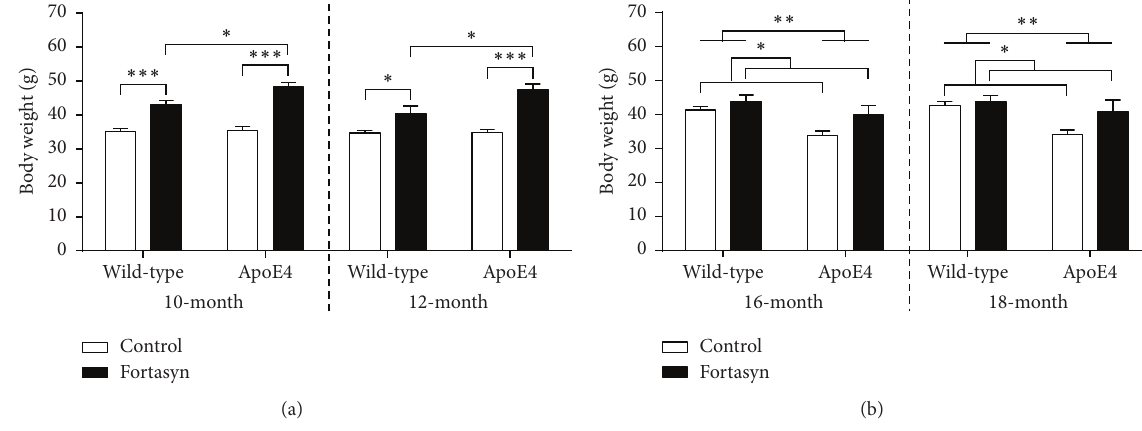
Figure 2: Body weight was measured in 10–12-month-old (a) and 16–18-month-old ApoE4 and wild-type (WT) mice. (a) At 10 months of age, ApoE4 and also wild-type mice on Fortasyn were significantly heavier than on control diet (ApoE4: 𝑝 < 0.001 ; wild-type: 𝑝 < 0.001 ). Only on Fortasyn diet was a genotype effect found showing a higher weight of ApoE4 mice compared with wild-type mice ( 𝑝 = 0.015 ). Again at 12 months of age, all animals on Fortasyn diet showed an increased body weight compared to animals on control diet (ApoE4: 𝑝 < 0.001 ; wild-type: 𝑝 = 0.019 ). ApoE4 mice on Fortasyn were heavier than wild-type mice on the same diet ( 𝑝 = 0.013 ). (b) At 16 and also 18 months of age, ApoE4 mice were significantly lighter than wild-type mice (16-month: 𝑝 = 0.003 ; 18-month: 𝑝 = 0.005 ). Furthermore, all animals on Fortasyn were heavier than animals on control diet (16-month: 𝑝 = 0.024 ; 18-month: 𝑝 = 0.042 ). ∗ 𝑝 ≤ 0.05 ; ∗∗ 𝑝 ≤ 0.01 ; ∗∗∗ 𝑝 ≤ 0.001